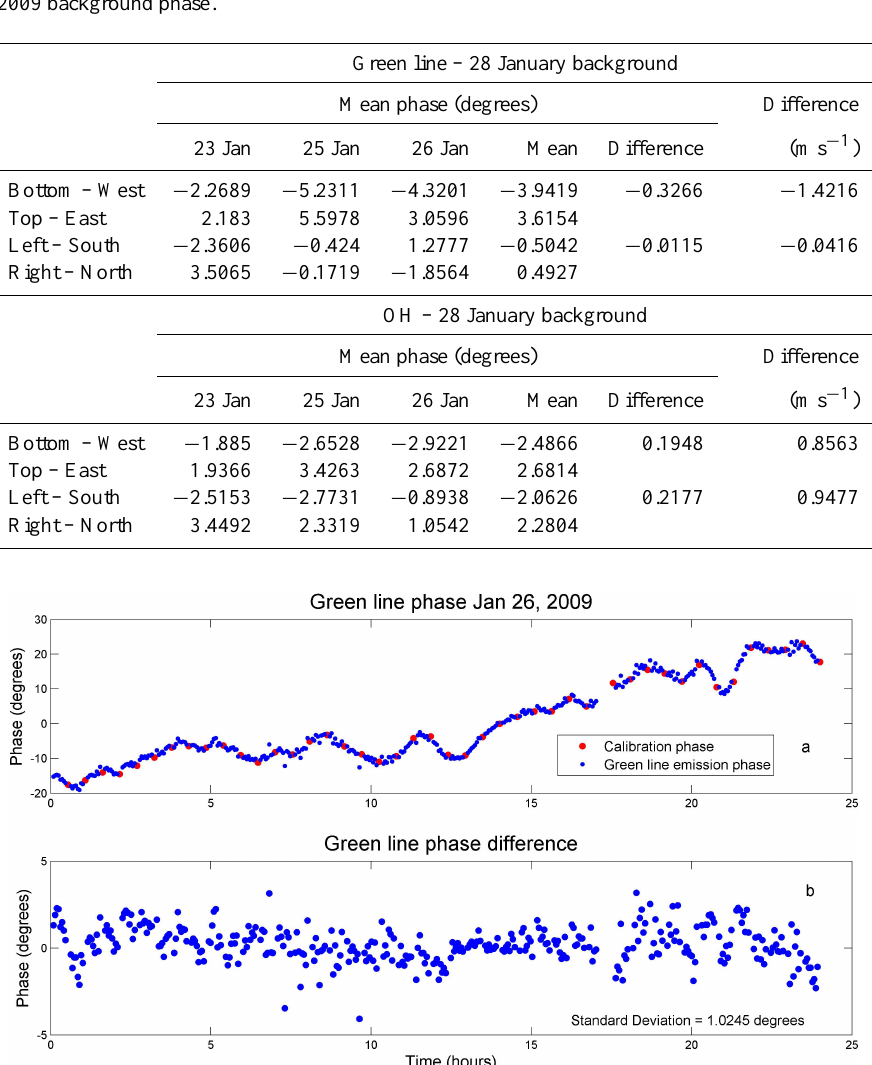
Fig. 5. (a) Plot of green-line-emission zenith phase (blue dots) and the calibration phase (red dots) on 26 January 2009. The measurement uncertainty of the phase measurements is smaller than the size of the dots in this plot. (b) Plot of the difference between the zenith phase and the calibration phase interpolated using cubic splines to the times of the atmospheric observations. The zenith observations include geophysical variability. The time is